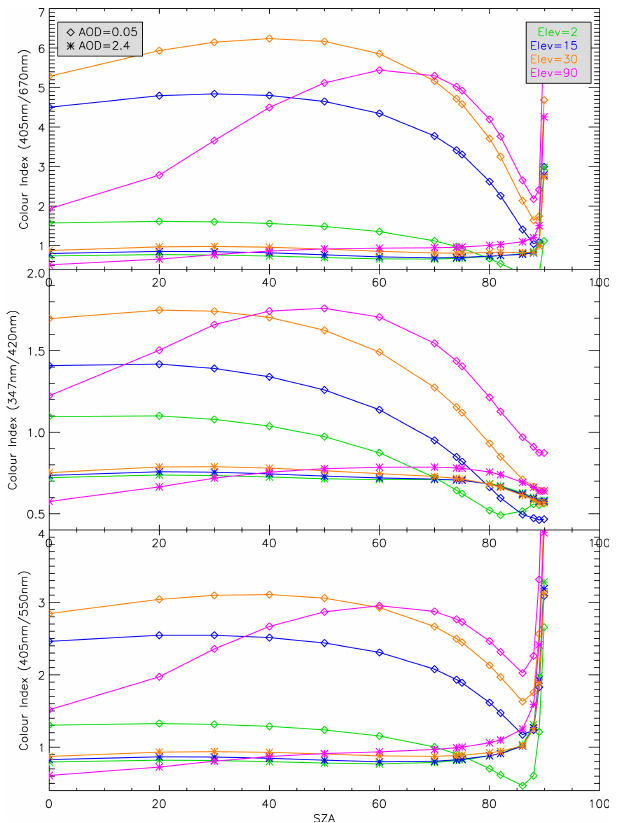
Figure 3. Simulations of the colour index under varying AOD and using the wavelengths corresponding to the three different measure- ment sites, respectively Xianghe, Brussels and Jungfraujoch from top to bottom. The simulations were performed with the DAK plan- parallel radiative transfer model (Stammes, 2001), using a cloud- layer height of 1km and a cloud optical depth of 0.